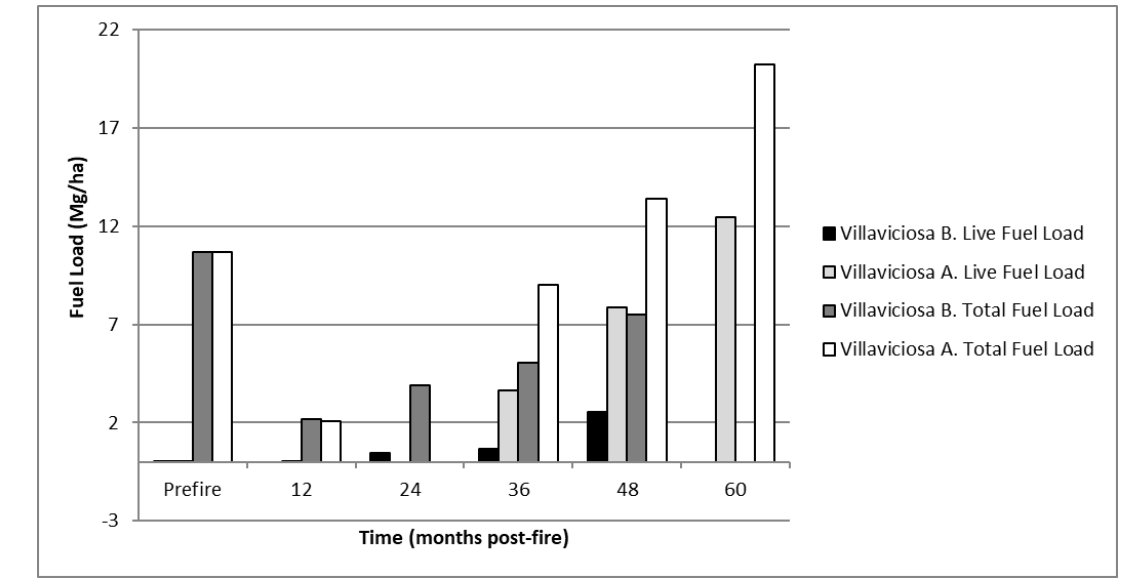
Forests 2021 , 12 , x FOR PEER REVIEW Figure 9. Dynamics of total fuel load and live fuel load in Villaviciosa A and Villaviciosa B.